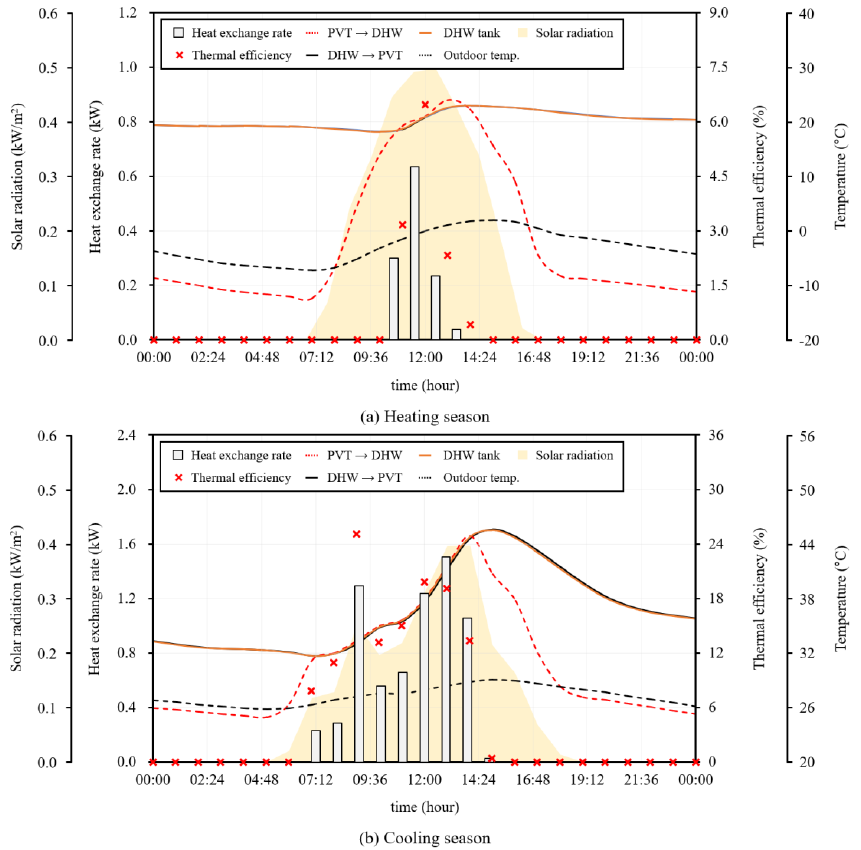
Figure 7. Thermal performance of the PVT module; ( a ) heating season, ( b ) cooling season.